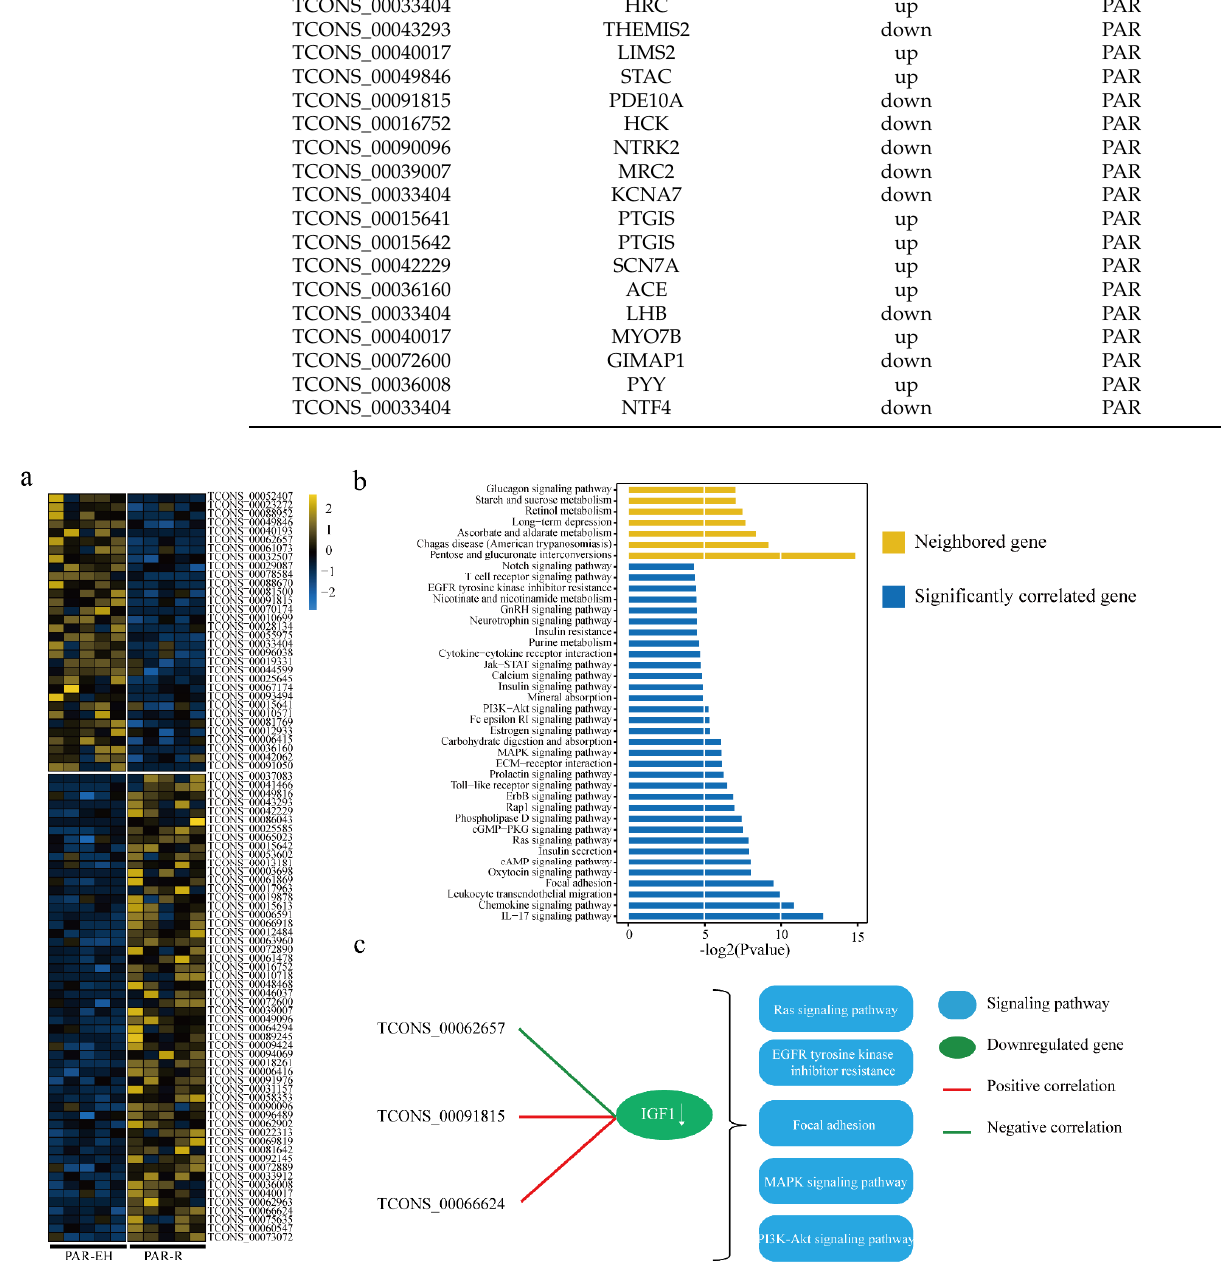
Figure 4. Functional analysis of differentially expressed lincRNAs (DELs) in mammary parenchyma (PAR) under enhanced milk replacer (EH) vs restricted milk replacer (R). ( a ) Heat map of DELs in PAR under EH vs R. ( b ) Pathway analysis of DELs’ neighboring genes and significantly correlated genes (yellow, represent DELs’ neighboring genes; blue, represent significantly correlated genes) in PAR. ( c ) Selected DELs that are highly correlated with DEGs. (Arrow represent the genes were involved in those pathways)